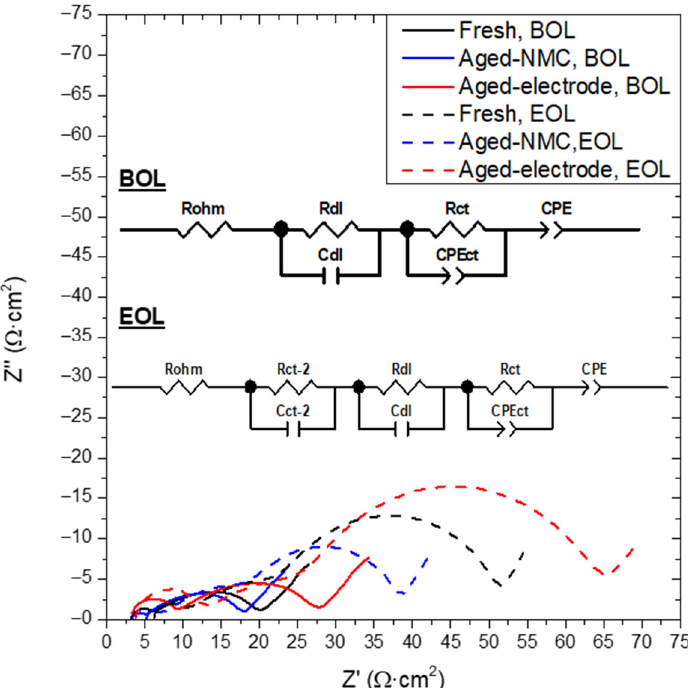
Figure 2. Nyquist diagrams of a representative cell per type of positive electrode: fresh (black lines), aged-NMC (blue lines) and aged-electrode (red lines). Continuous and dashed lines are used for the spectra obtained at the beginning and the end of life, respectively. The equivalent circuits for the fitting of the spectra are also included.